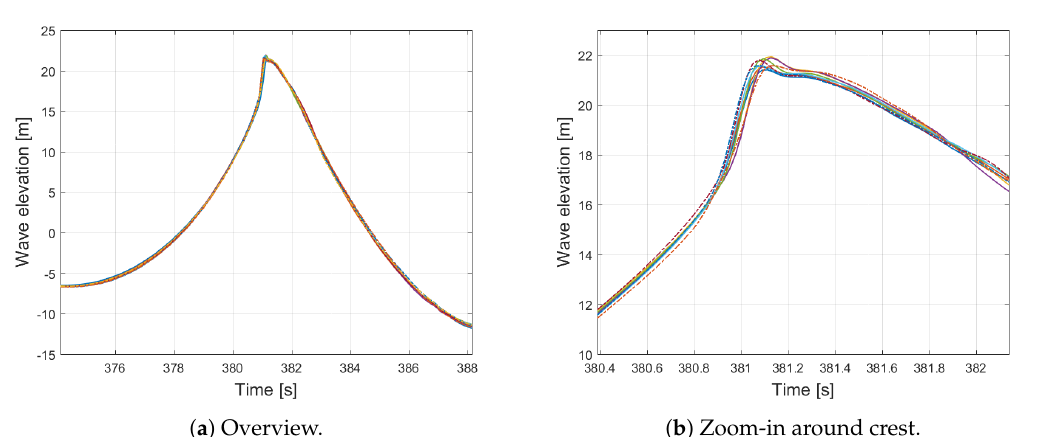
Figure 19. Repeatability of focused Wave 1 in atmospheric condition. Figure based on the same data as a figure in